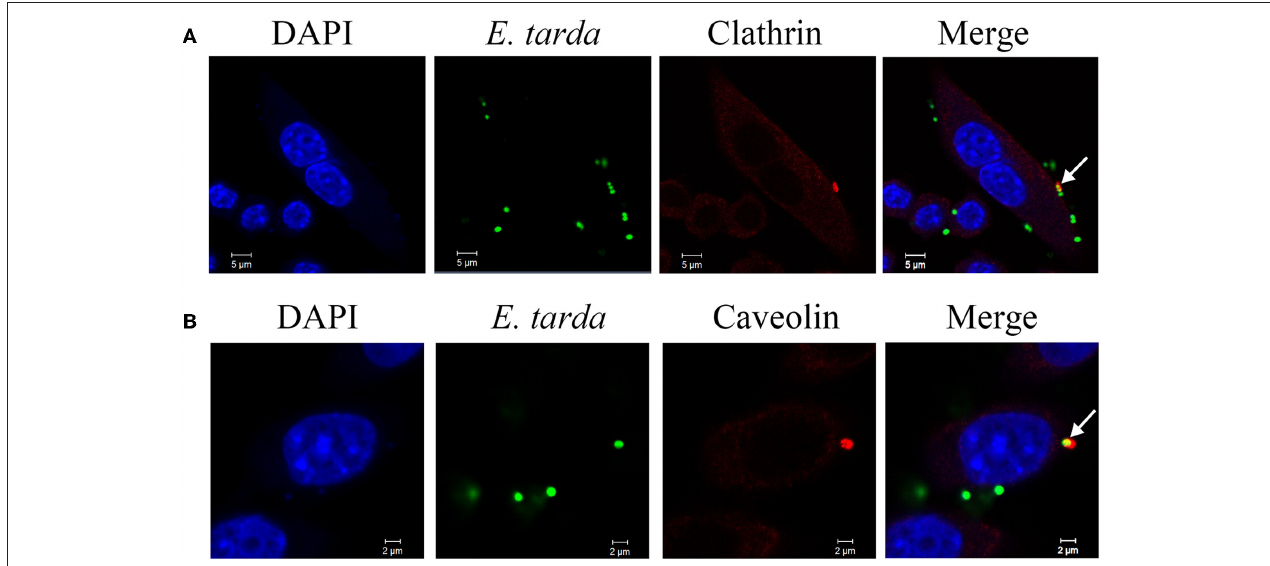
FIGURE 3 | Co-localization of Edwardsiella tarda with clathrin (A) and caveolin (B) during bacterial infection of RAW264.7. RAW264.7 cells infected with E. tarda TX1G for 30 min were treated with Alexa Fluor594-labeled antibody against clathrin or caveolin. The cells were stained with DAPI and observed with a confocal microscope. White narrows indicate co-localization of bacteria and